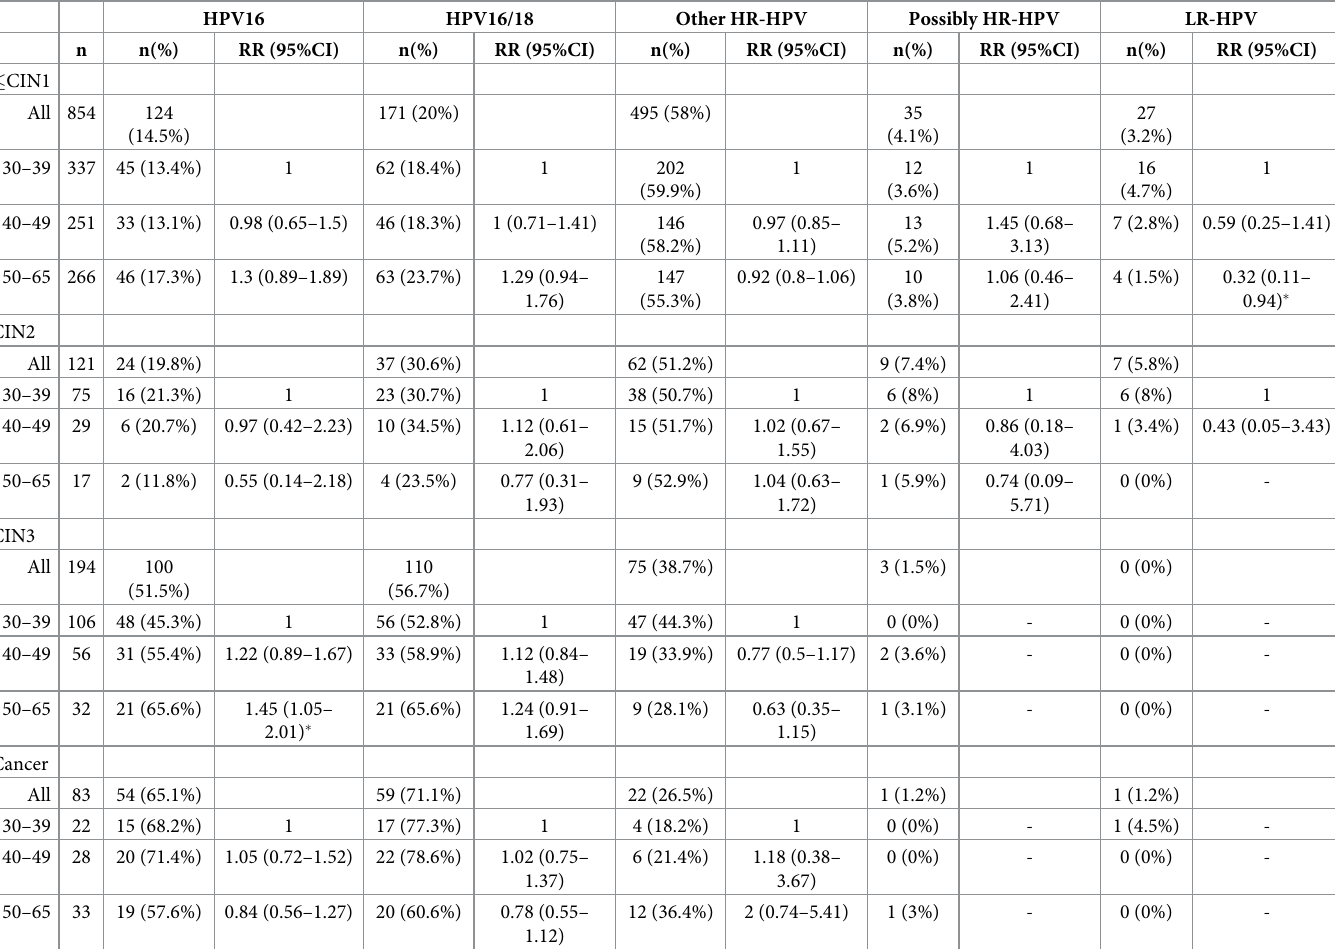
Table 5. Association between HPV16 and HPV risk-based groups infections with age within histological diagnoses in HPV screened positive